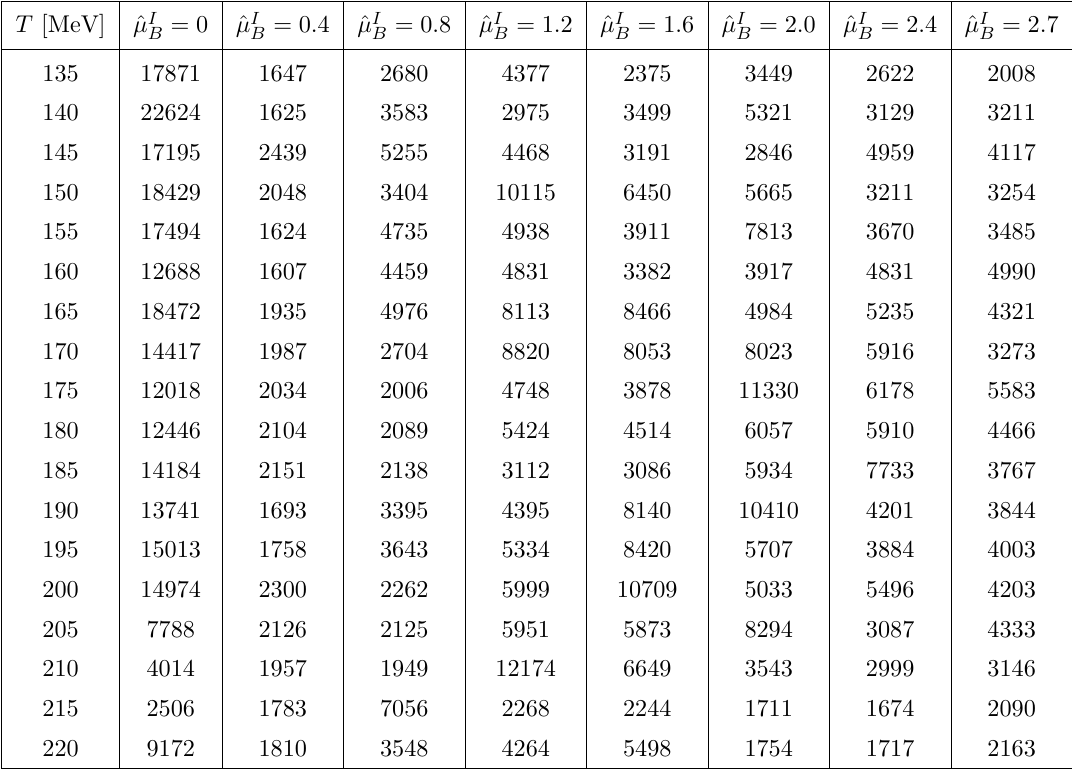
Table 1 . Statistics of our simulations on the 48 3 (cid:2) 12 lattice. We list the number of stored and analyzed gauge con(cid:12)gurations. These con(cid:12)gurations were separated by ten Rational Hybrid Monte Carlo updates.